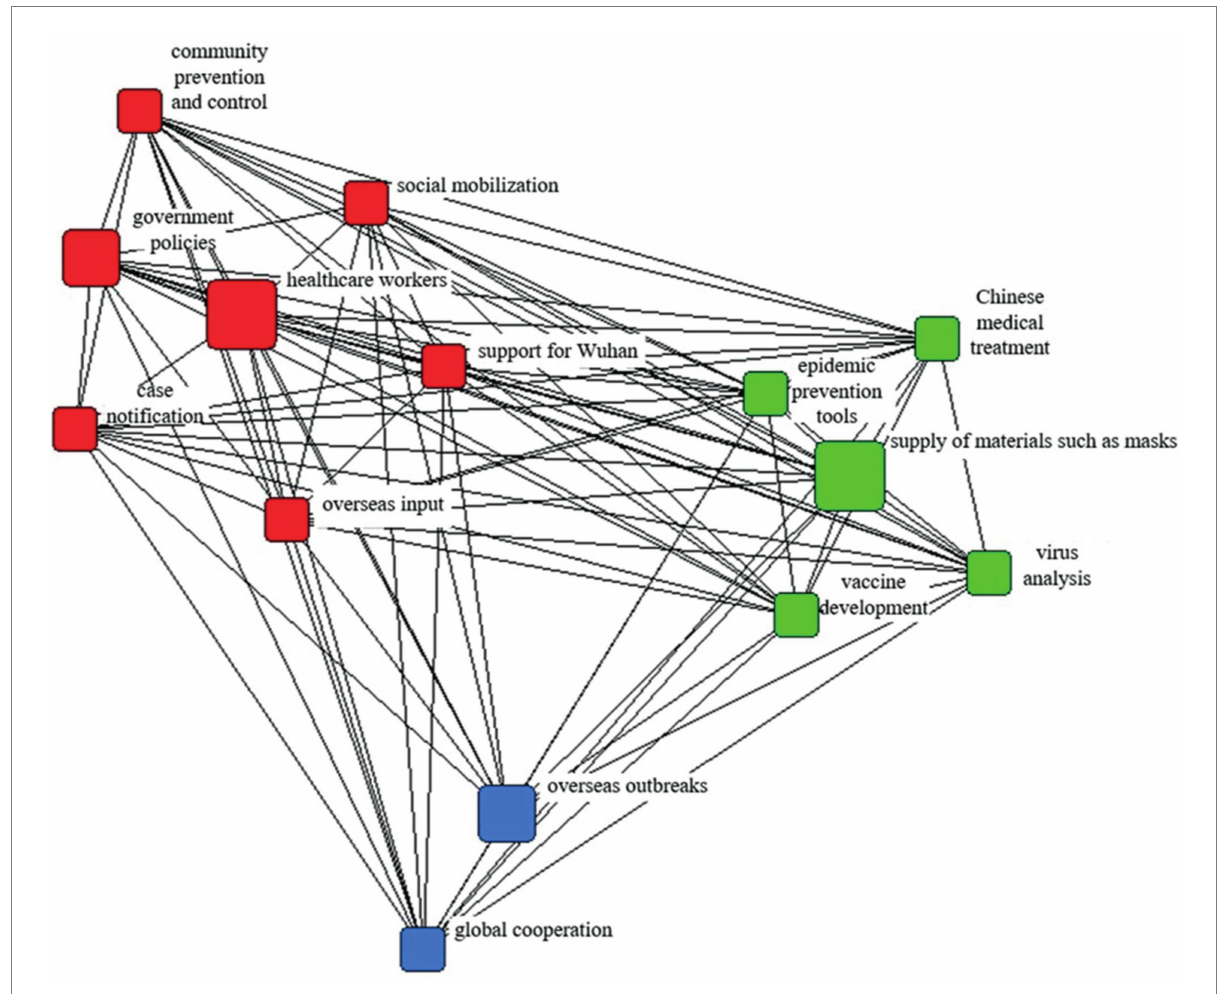
FIGURE 4 The network of the explicit public